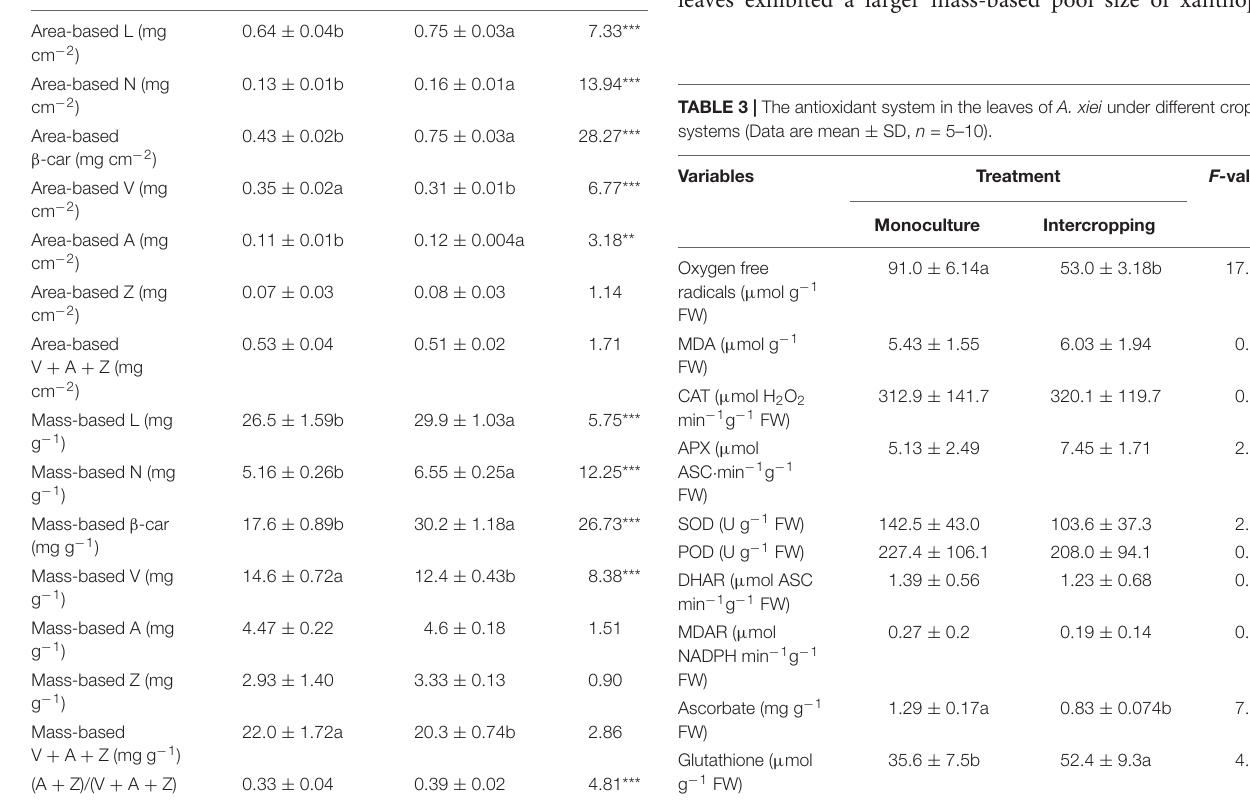
TABLE 2 | Photoprotective-related parameters in the leaves of A. xiei under different cropping systems (Data are mean ± SD, n = 5–10). Variables Treatment F- values Monoculture